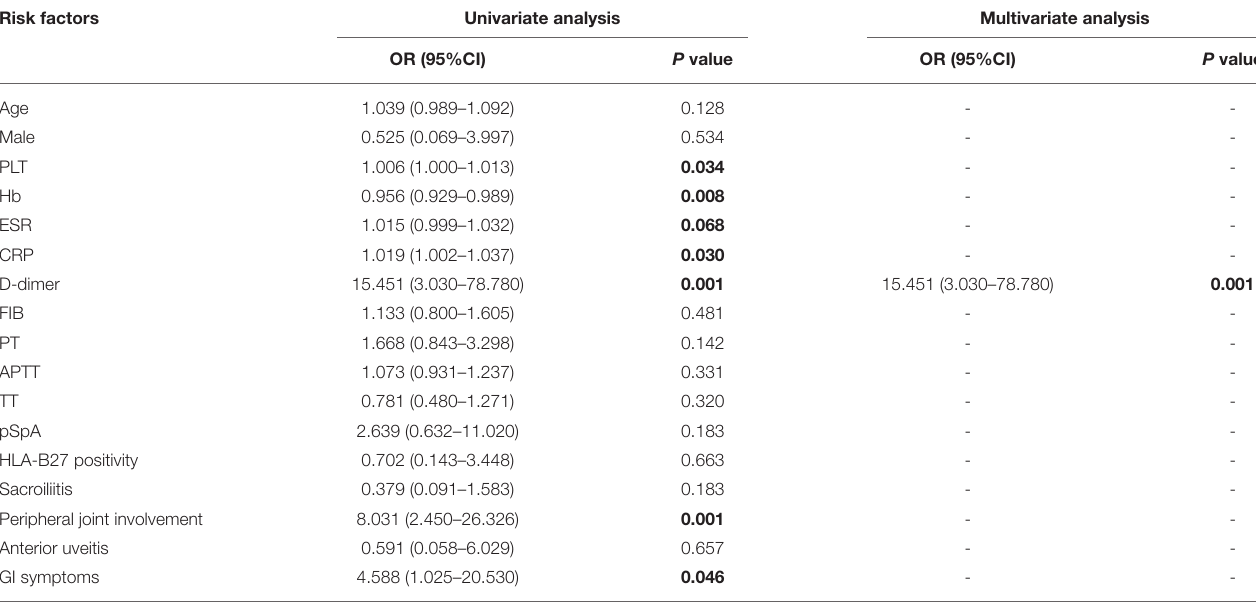
TABLE 4 | Binary logistic regression analysis of gut inflammation in